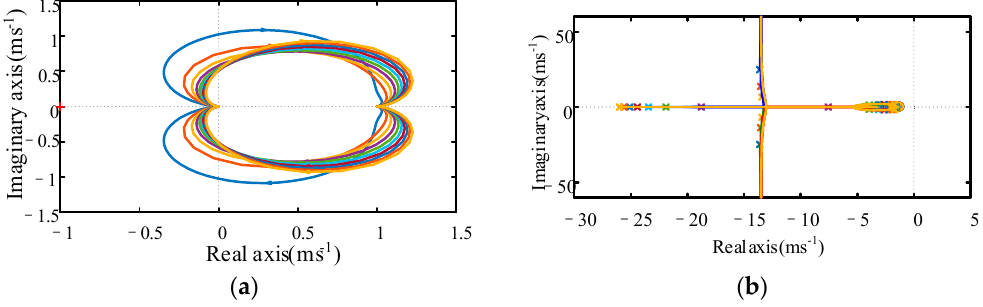
Figure 12. ( a ) Root locus and ( b ) Nyquist curves of the voltage transfer function.